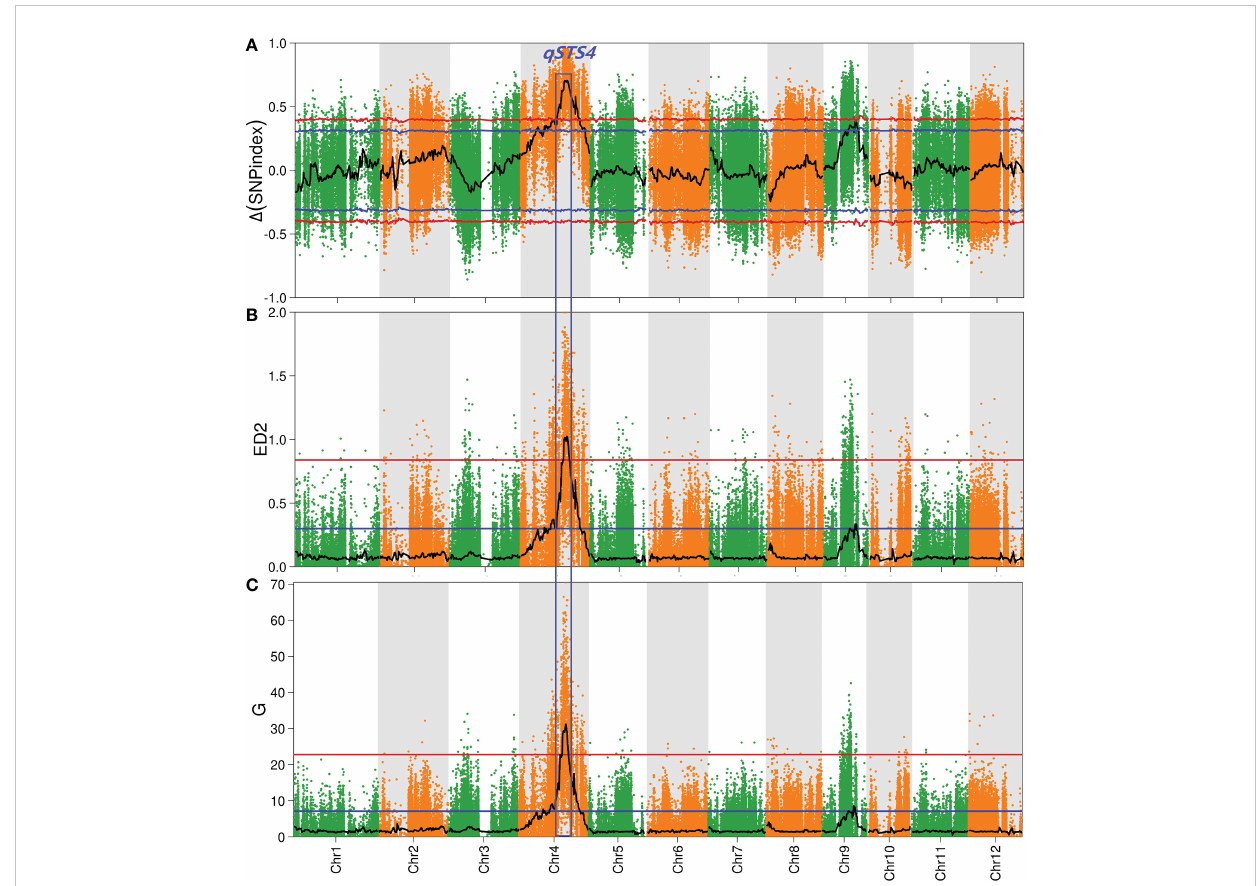
FIGURE 2 Quantitative trait locus (QTL) analysis of rice salt tolerance at seeding stage by QTL-seq. (A – C) represent Manhattan plots of D (SNP-index), Euclidean distance (ED2) and G-value on chromosomes, respectively. The blue and red lines represent the 95% and 99% con fi dence intervals, respectively, and the black line represents the mean of the four algorithms, plotted using sliding window analysis. The numbers on the horizontal coordinates represent chromosome